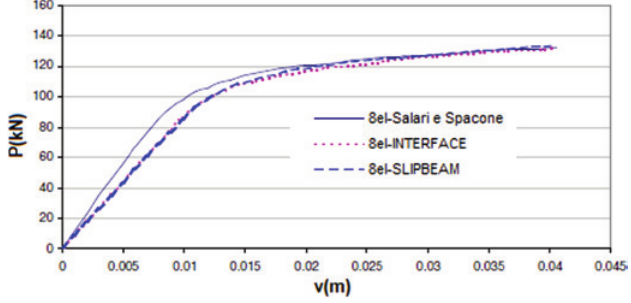
Load-displacement curve for a point in the mipspan of the composite beam